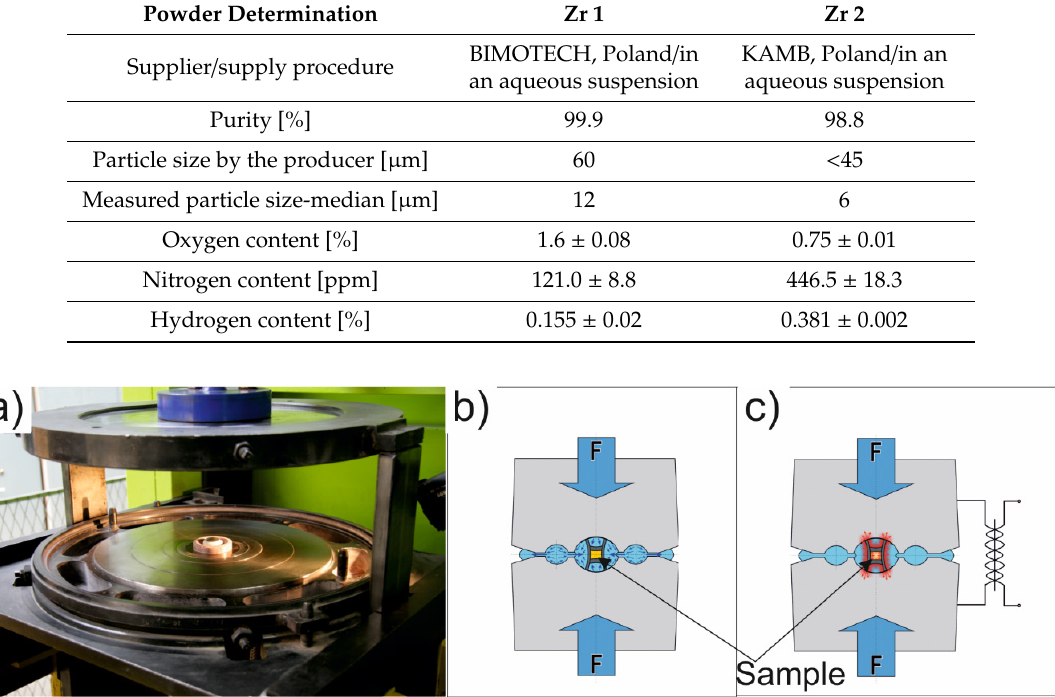
Table 1. Purity and particle sizes of zirconium powders.